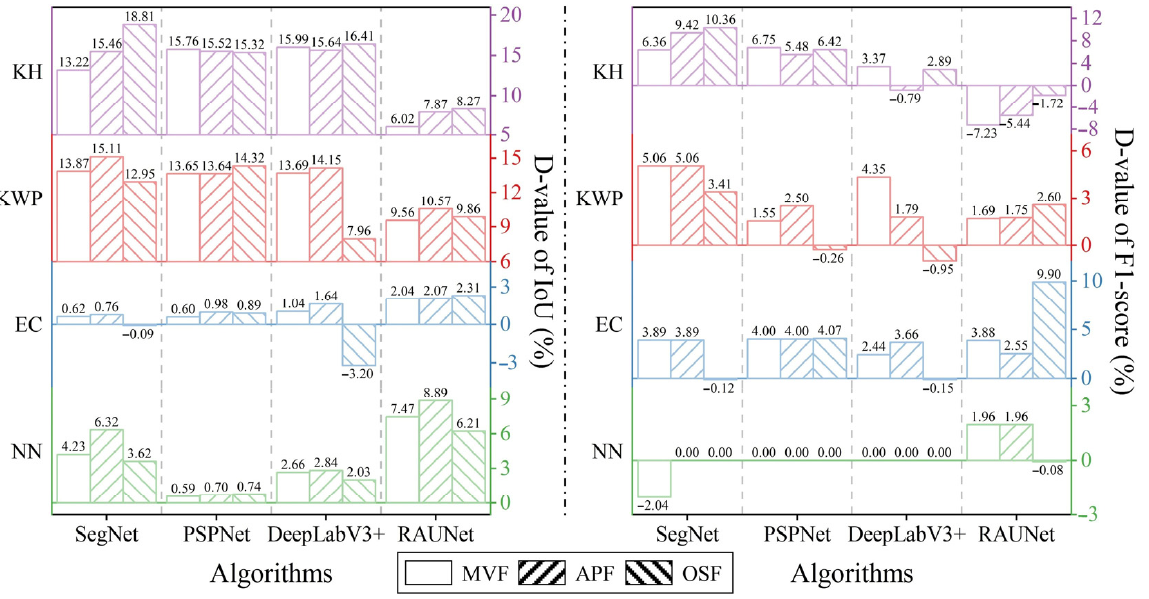
Figure 19. Differences in accuracy between the OC-FCM and the MC-FCM based on different algorithms for karst wetland vegetation.